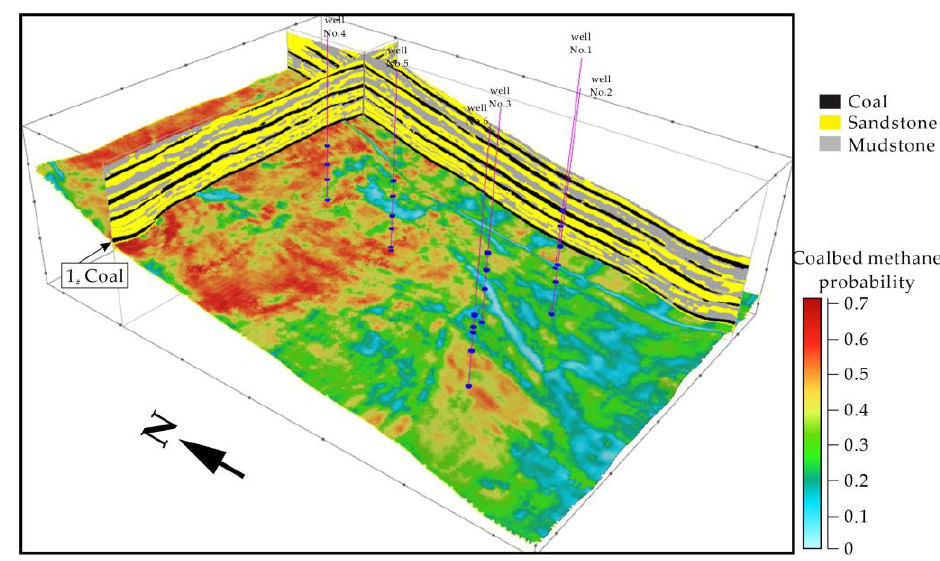
Figure 15. 1 # coal seam gas reservoir distribution map.